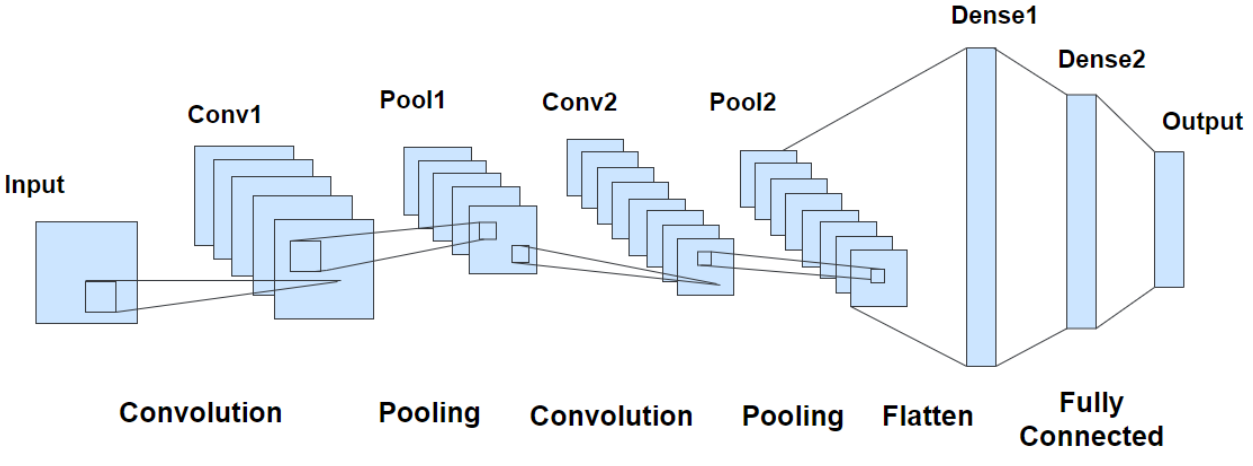
Figure 3. Architecture of CNN used for classification of